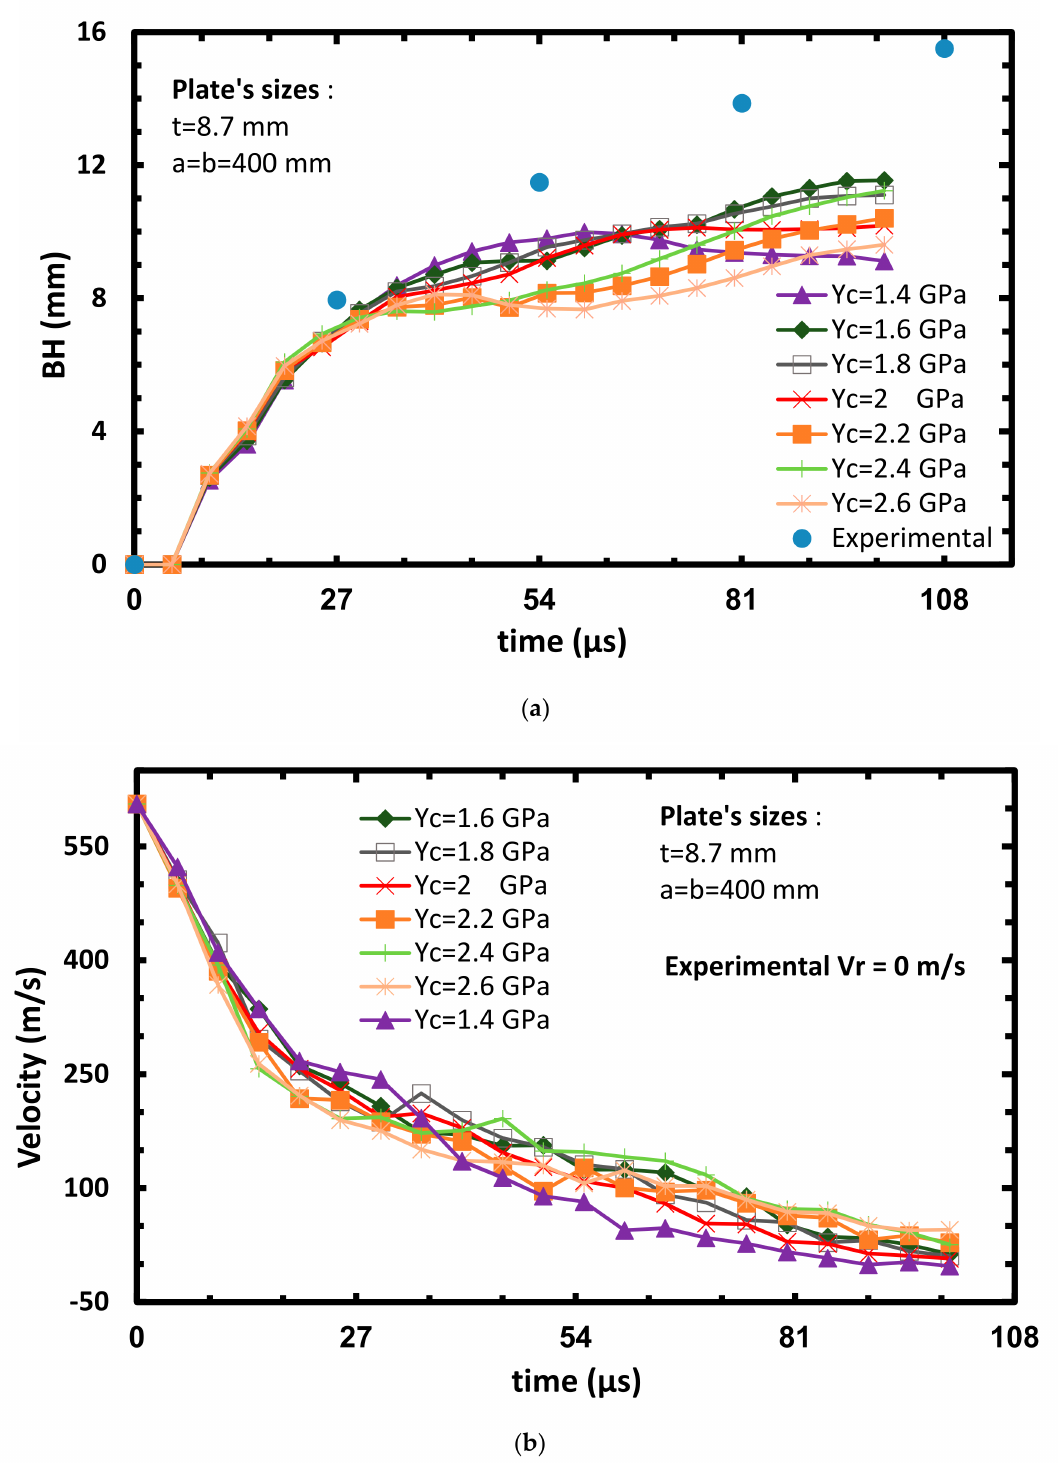
Figure 8. Plate’s bulge height ( a ) and projectile’s velocity ( b ) vs. time at varying Yc, Vinitial = 606